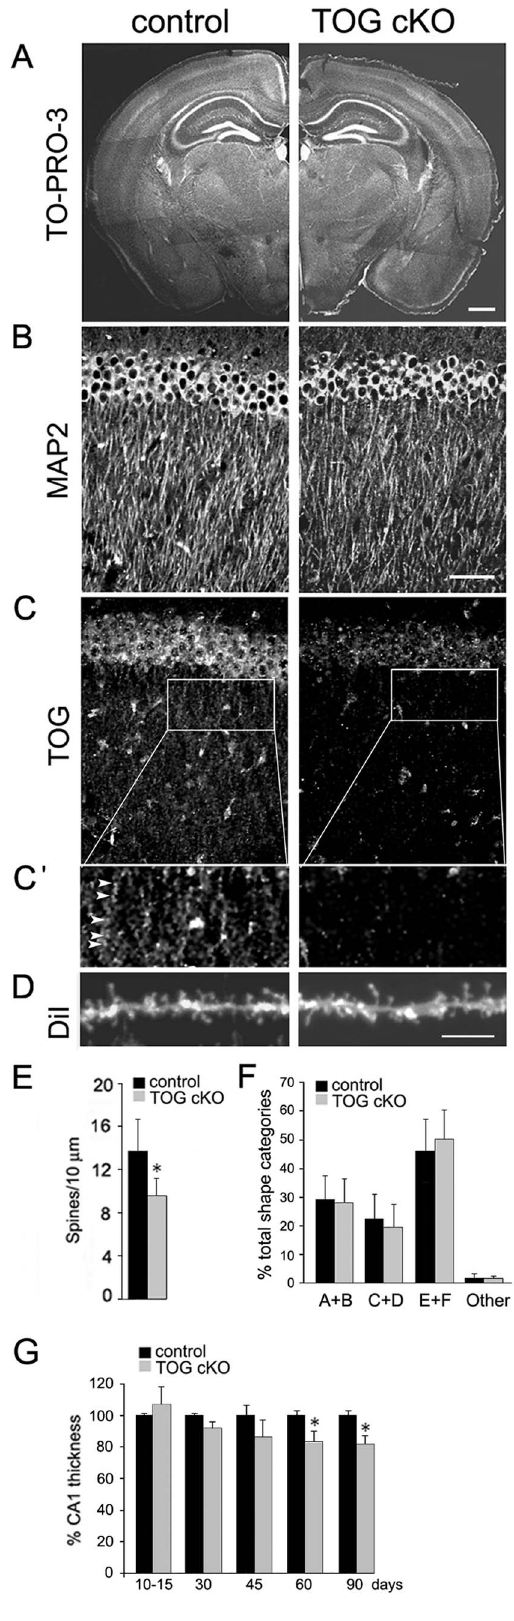
Figure 2. Neuronal and dendritic spine morphology in control and TOG cKO hippocampus. A. Coronal brain sections from 60